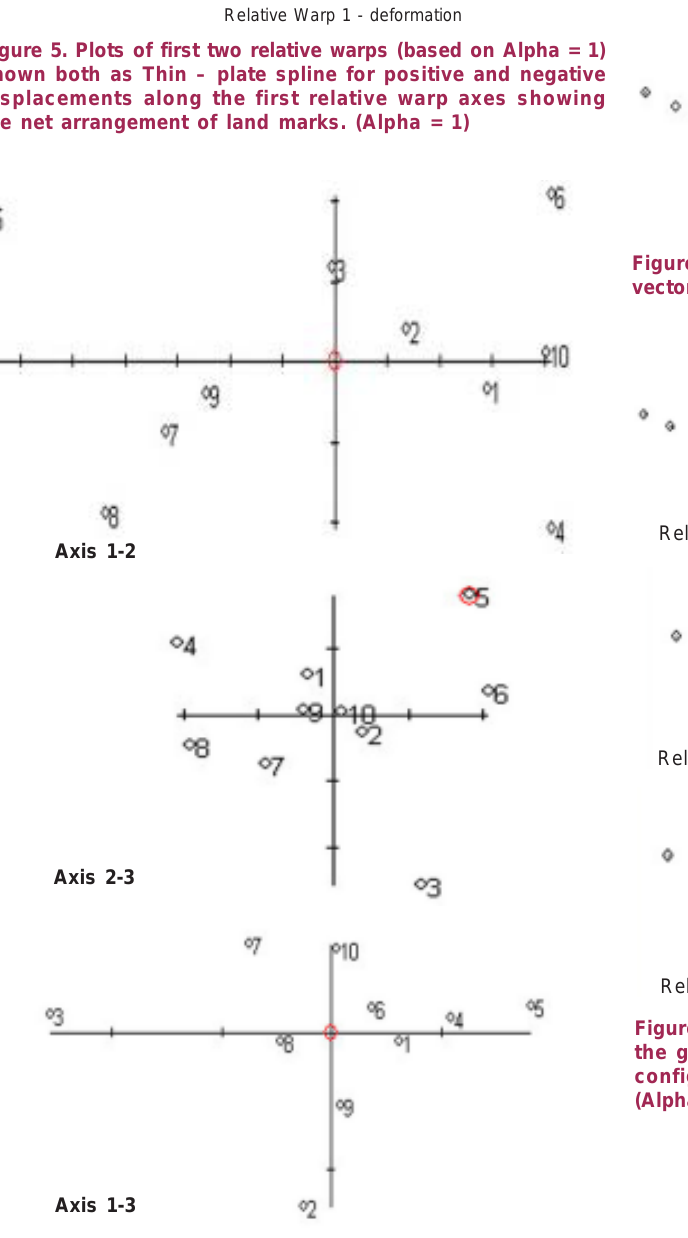
Figure 6. Ordination by the non-affine shape 1st , 2nd and 3rd components for Culex quinquefasciatus male and females (Alpha =